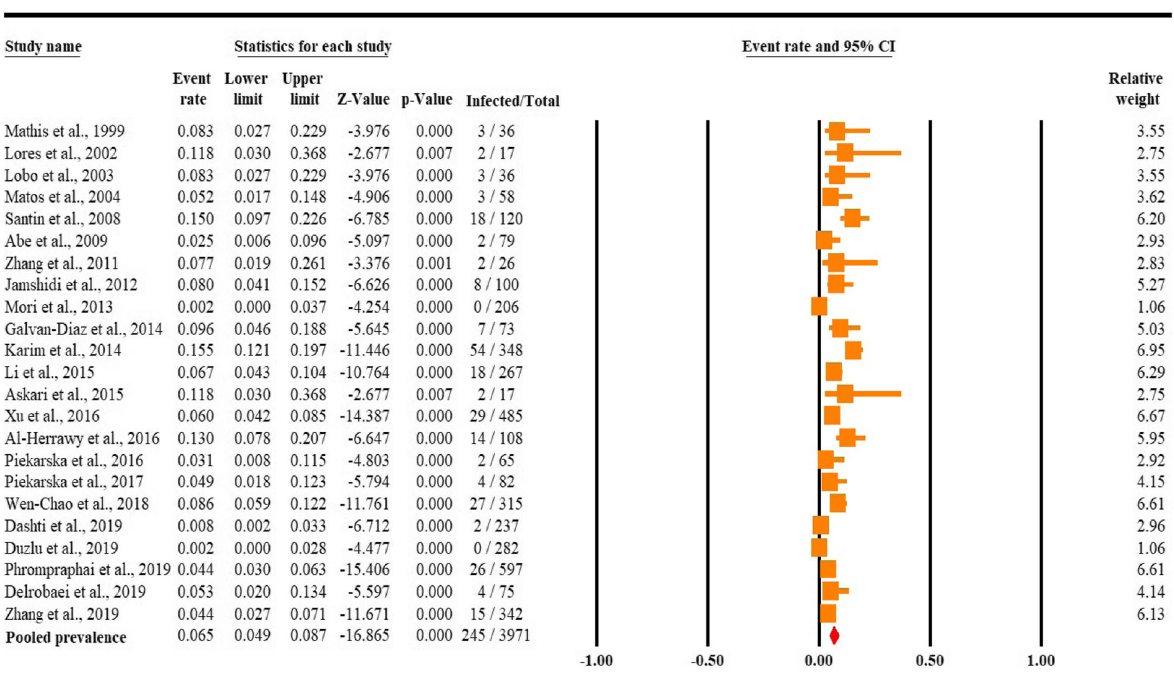
Fig. 2 The pooled molecular prevalence of E. bieneusi infection in